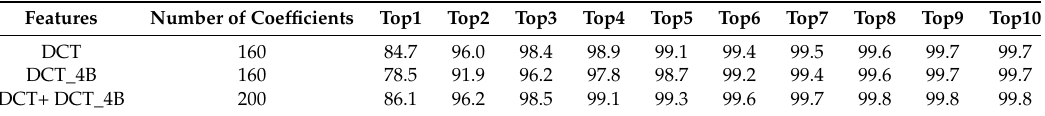
Table 1. Clustering accuracy rate (percent) of Simplified Arabic font vs. number of clusters using three features (codebook size = 1024, lexicon (cid:39) 356,000).